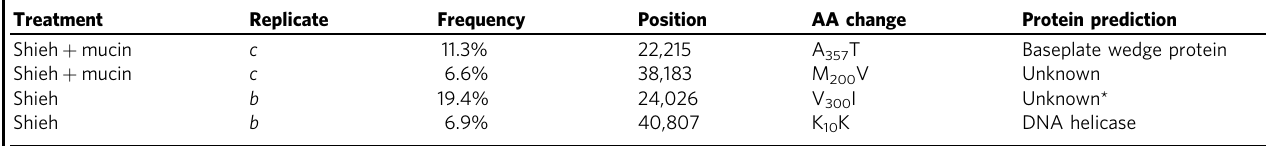
Fig. 7 Competition experiment with Aeromonas sp . and Rhizoid (Z) and Rough (R) F. columnare in lake water + mucin. Y-axis shows mean bacterial cell numbers of three replicate cultures. Plots smoothed using the loess function in R, with grey areas indicating 95% con fi dence interval across the replicates. Source data are provided as a Source Data fi le. Table 1 Mutations discovered in phage genomes on the population level.